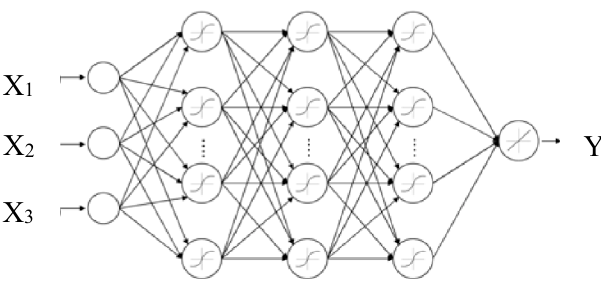
Figure 1. Architecture of the ANN with Multi-Layer Perceptron (MLP), with three inputs and one